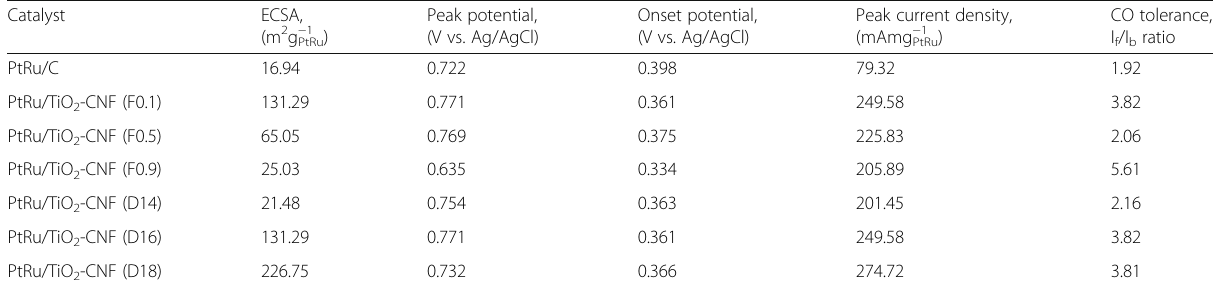
Table 5 Summary of the peak potential, current density, CO tolerance, and ECSA results for the catalyst with the different electrospinning parameter Catalyst